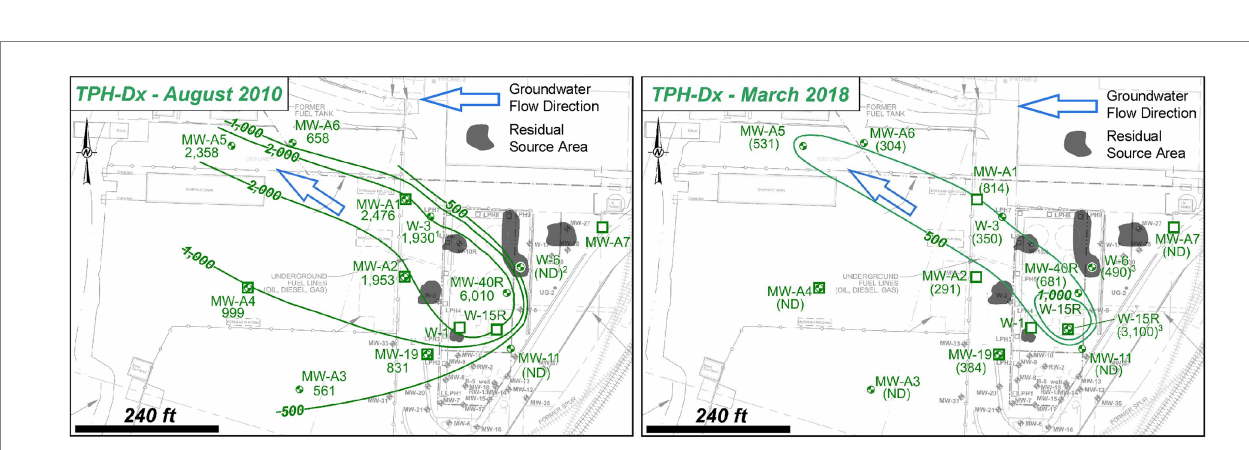
FIGURE 2 Site 2 overview showing shallow groundwater TPH-Dx plume contraction between August 2010 and March